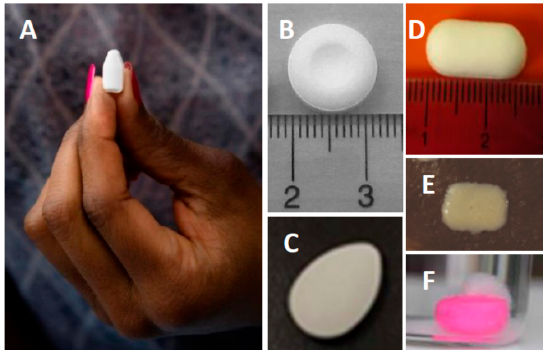
Figure 1. Representative images of topical inserts in development: ( A ) CONRAD’s Tenofovir Alafenamide Fumarate/Elvitegravir (TAF/EVG) insert, ( B ) CONRAD’s first generation insert, Tenofovir/Emtricitabine (TFV/FTC), ( C ) IPM’s DS003 vaginal tablet (photo courtesy of Jeremy Nuttall, IPM), ( D ) Population Council and PATH’s Griffithsin/Carrageenan (GRFT/CG) fast-dissolve insert (photo courtesy of Tom Zydowsky, The Population Council) [20] , ( E ) Osel’s MucoCept Lactobacillus vaginal tablet (Reproduced from [21] , under the terms of the CC BY 4.0 license), ( F ) prototype extended-release EVG osmotic insert, evaluated preclinically by CONRAD in collaboration with Patrick Kiser (Northwestern University, Evanston, IL, USA).